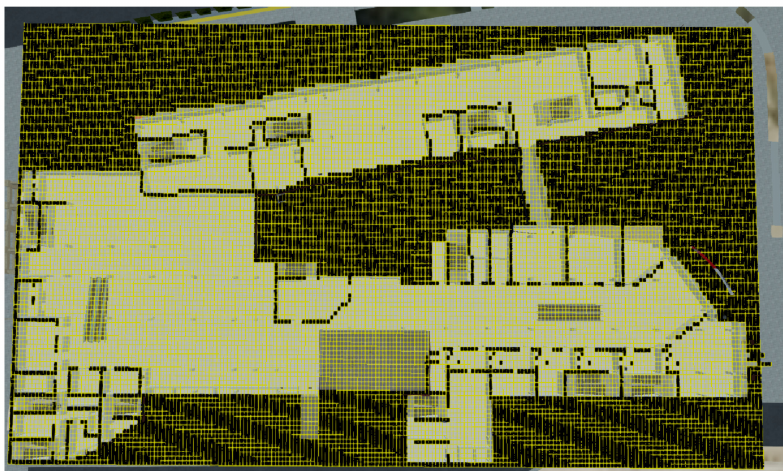
Figure 14. BIM model analysis to generate indoor grid topology